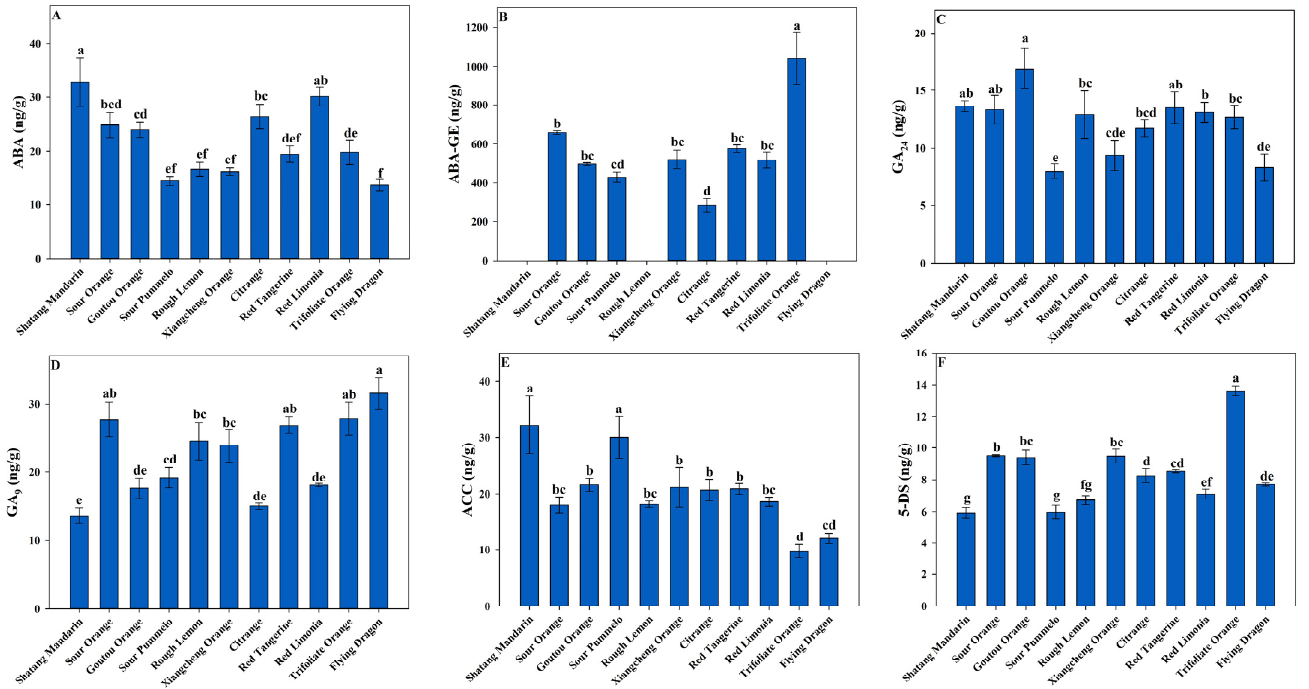
Figure 5. Endogenous abscisic acid, gibberellin, ACC, and 5DS concentrations in leaf tissues of ‘Shatangju’ scion cultivar grafted onto different rootstocks. ABA = Abscisic acid ( A ), ABA-GE = ABA glucose ester ( B ), GA 24 ( C ), GA 9 ( D ), ACC = 1-aminocyclopropanecarboxylic acid ( E ) and 5DS = 5- deoxystrigol concentrations ( F ). Error bars indicate the standard error of three biological replicates, and lowercase letters indicate significant differences between rootstocks by LSD ( p ≤ 0.05).